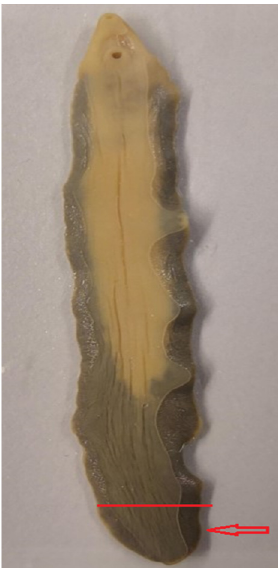
Figure 1. Morphology of an adult Fasciola gigantica fluke. The red line shows the area where the incision of the helminth was performed, and the red arrow indicates the posterior body part that was used for molecular analysis and MALDI-TOF